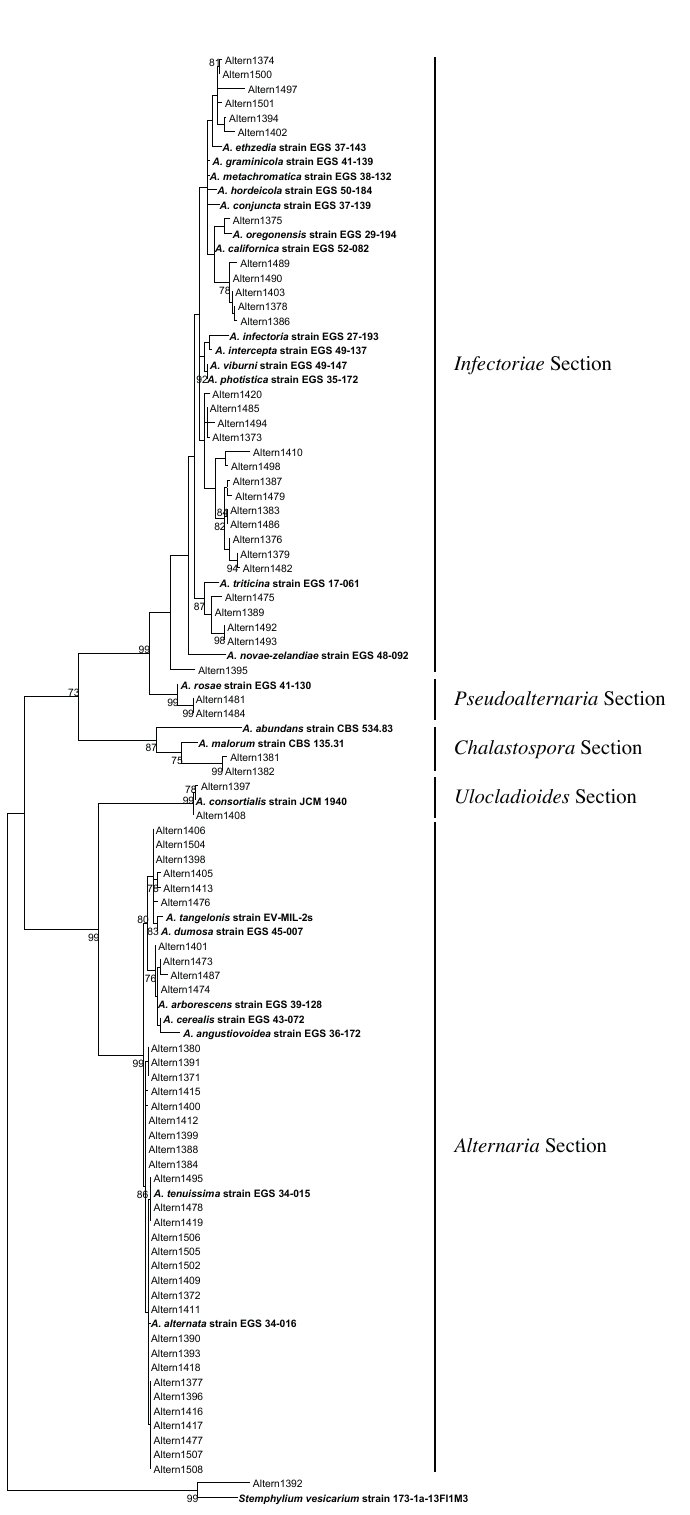
Figure 1. Phylogenetic tree generated by maximum likelihood analysis (bootstrap 1000 replicates) of combined gpd , calmodulin and β-tubulin gene sequences of 74 Alternaria field strains, 24 Alternaria reference strains, and rooted to Stemphylium . Bootstrap values greater than 70 are shown next to relevant